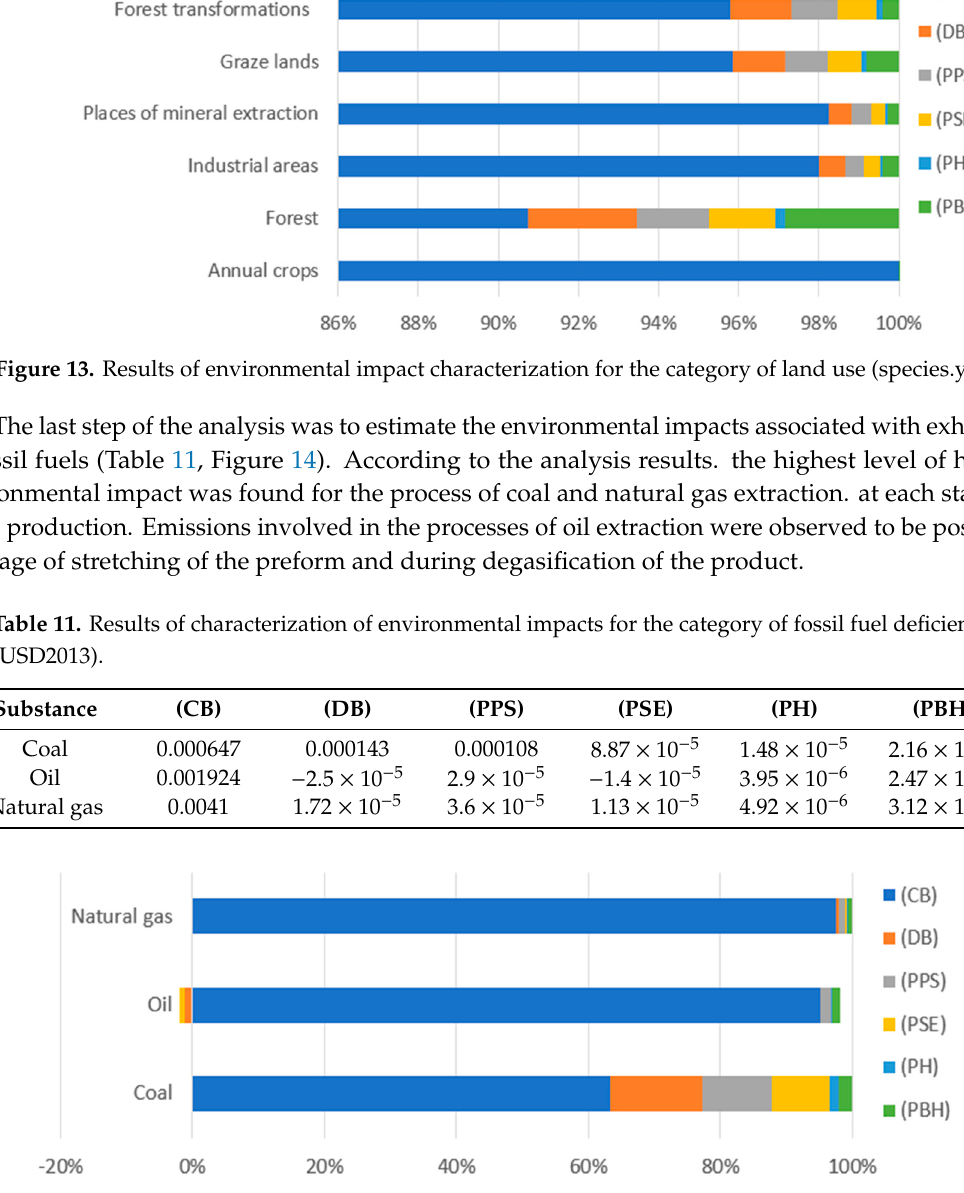
17 of 21 Figure 12. Results of environmental impact characterization for the category of land acidification (species.yr). The results of characterizing of environmental impacts of the processes connected with land use involved in a biodegradable bottle production process life cycle are presented in Table 10 and Figure 13. Of all the considered processes of the analyzed impact category. the highest level of negative environmental impact was reported for the process of agricultural cultivation whose value at the last stage was (2.64 × 10 − 10 species.yr). Such a big difference in particular levels of emission is caused by increased use of land for cultivation of corn for the production of corn starch. Table 10. Results of environmental impact characterizing for the category of land use (species.yr ) . Substance